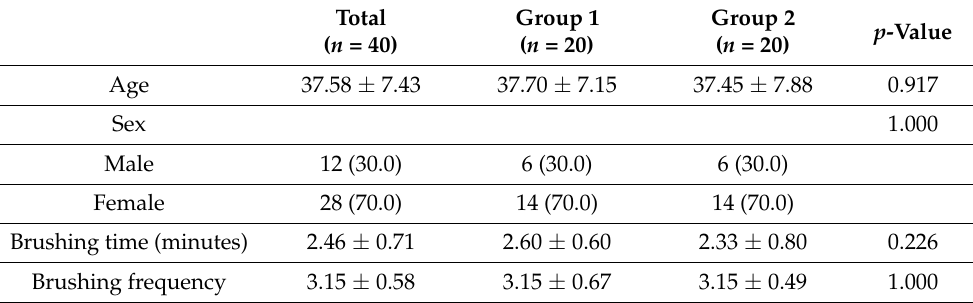
Table 1. Demographic of participants.